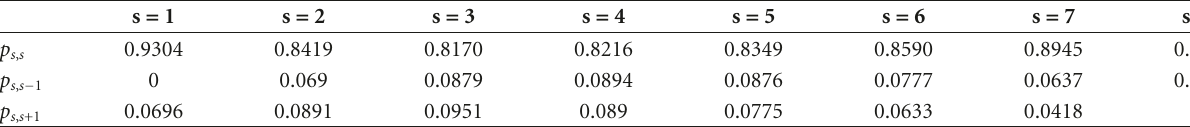
Table 1: Channel state transition probability.